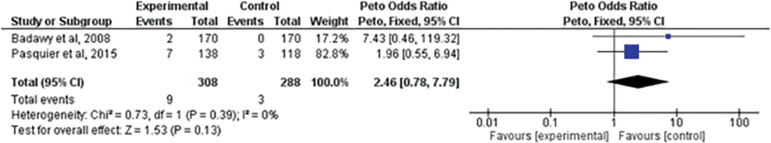
Forest-plot of congenital abnormality incidence with treatment